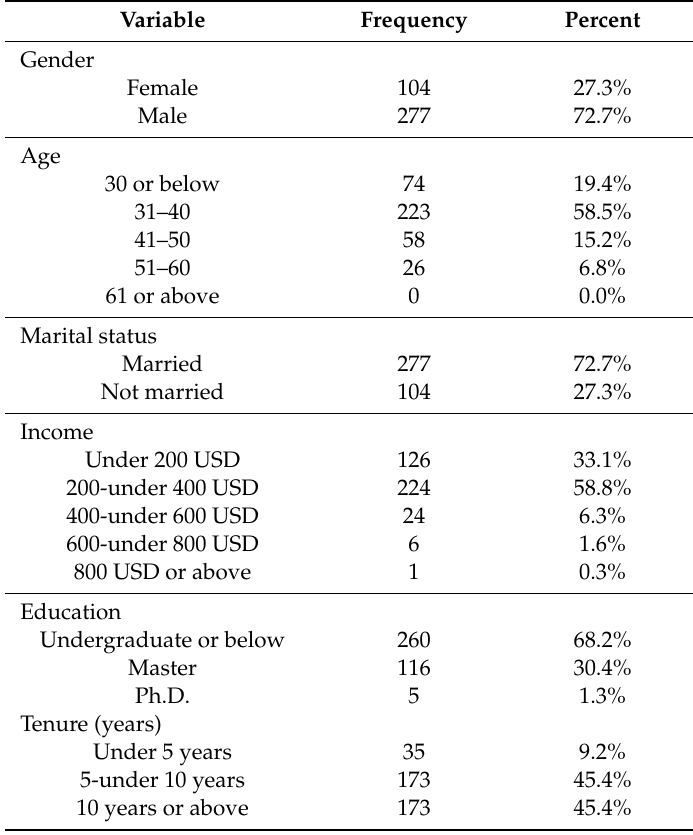
Table 2. Demographics of